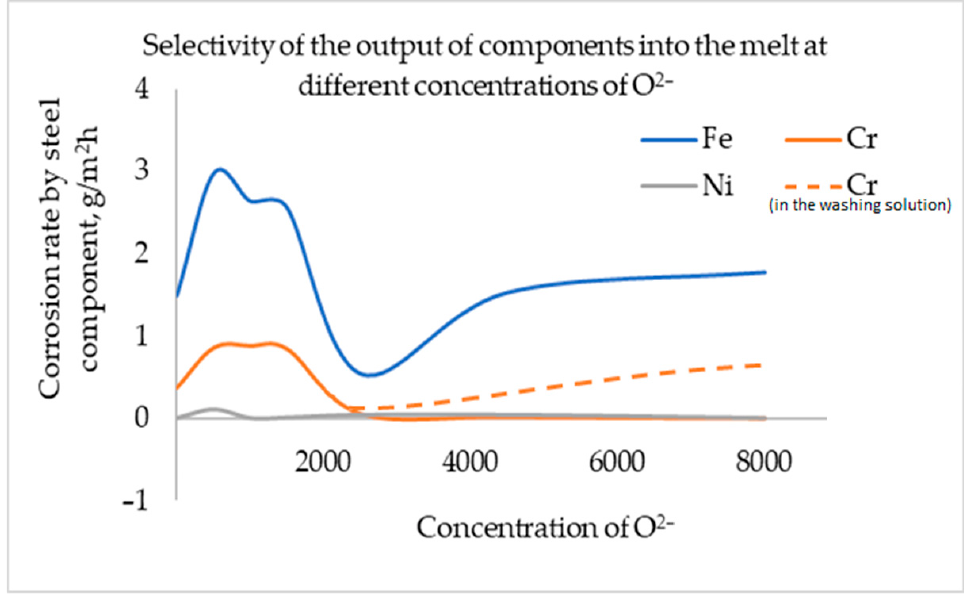
Figure 4. Selectivity of transition of steel components to melt depending on the concentration of lithium oxide additive in FLiNaK, according to elemental analysis.